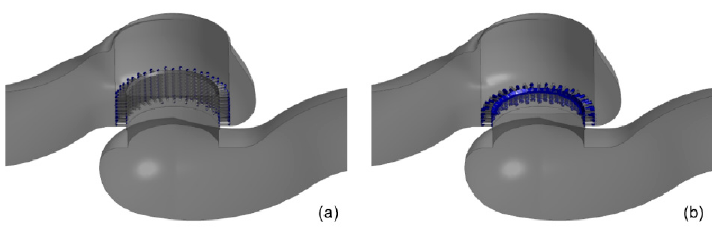
Figure 5. Vapor distributions inside the sleeve regulating valve for different valve core displacements ( a ) 60 mm; ( b ) 30 mm.